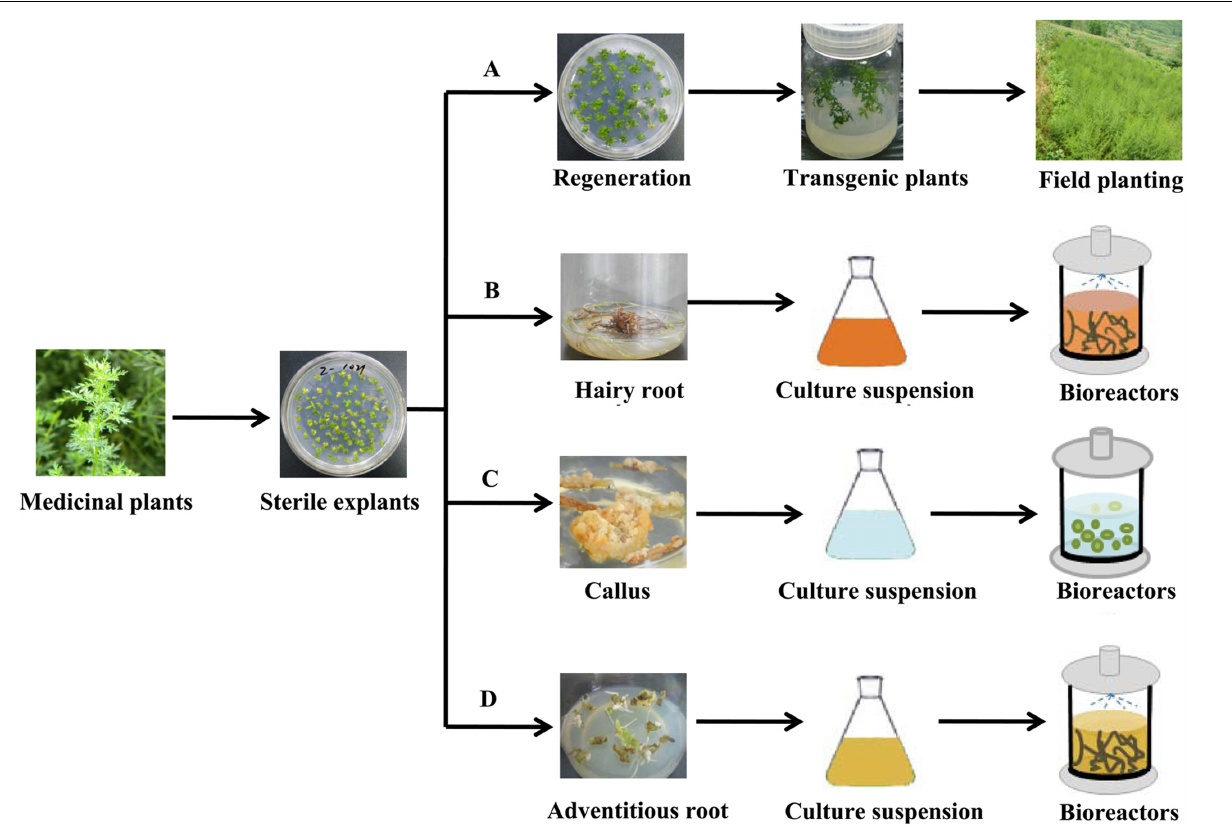
FIGURE 3 | The production of pharmaceutical terpenoids by plant metabolic engineering. (A) The cultivation of transgenic plants (B) Hariy root culture (C) Plant cell-suspension culture (D) Adventitious root culture.